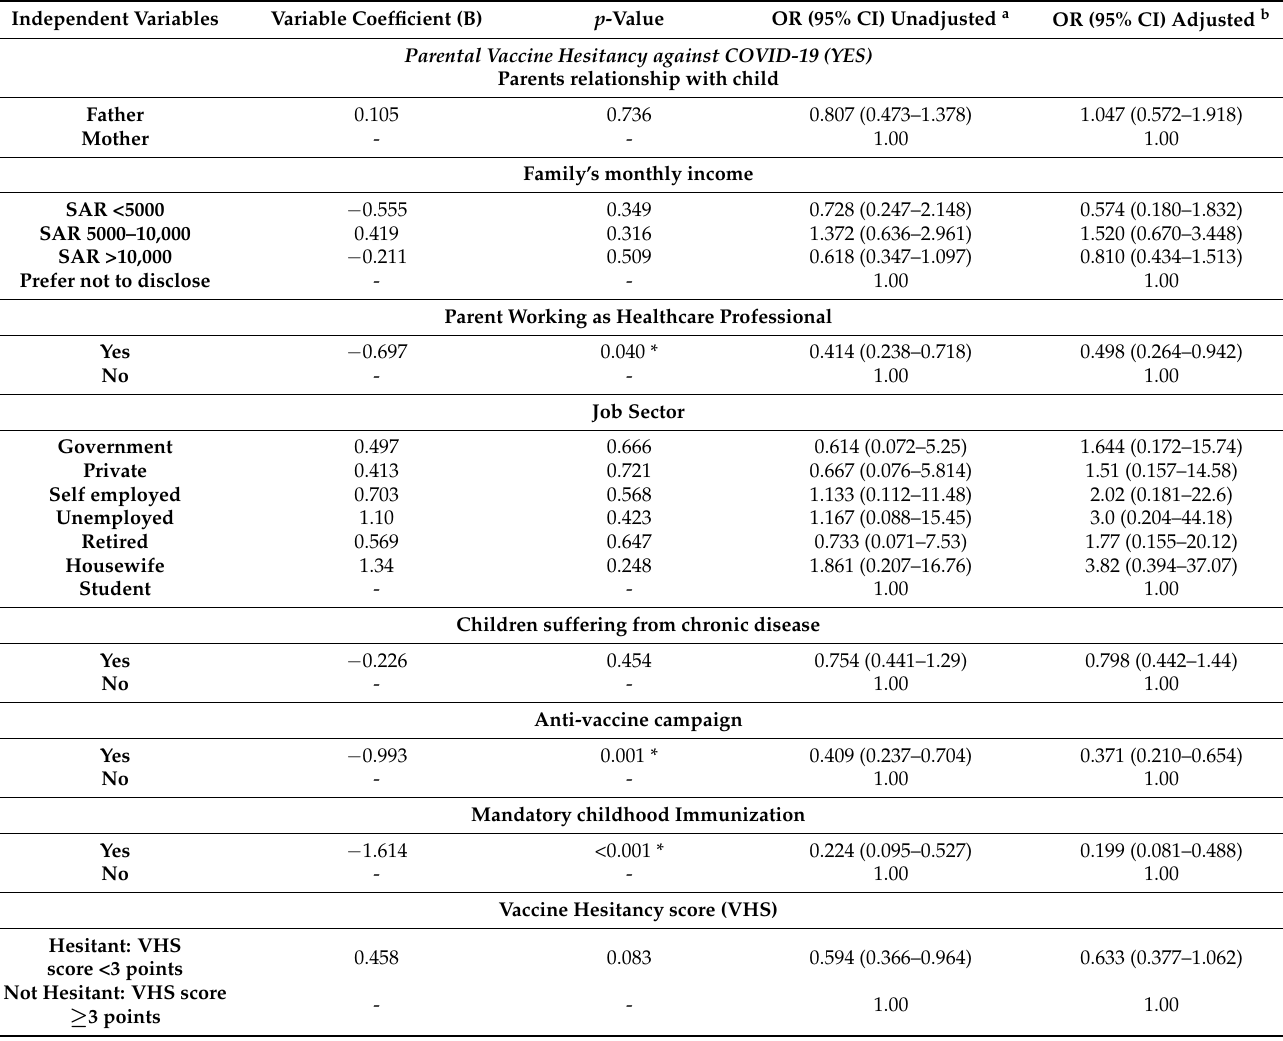
Table 5. Identifying the variables associated with parental intention to vaccinate their